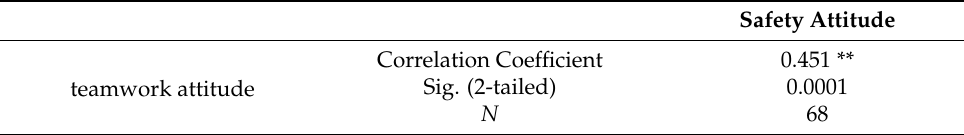
Table 4. Correlation among the factors affecting teamwork attitude and safety